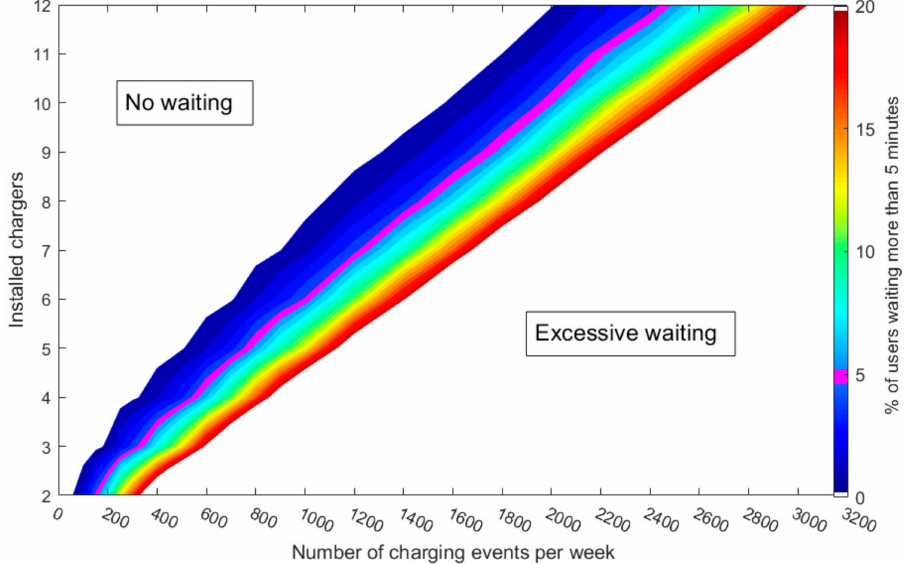
Figure 6. Percentage of users waiting more than 5